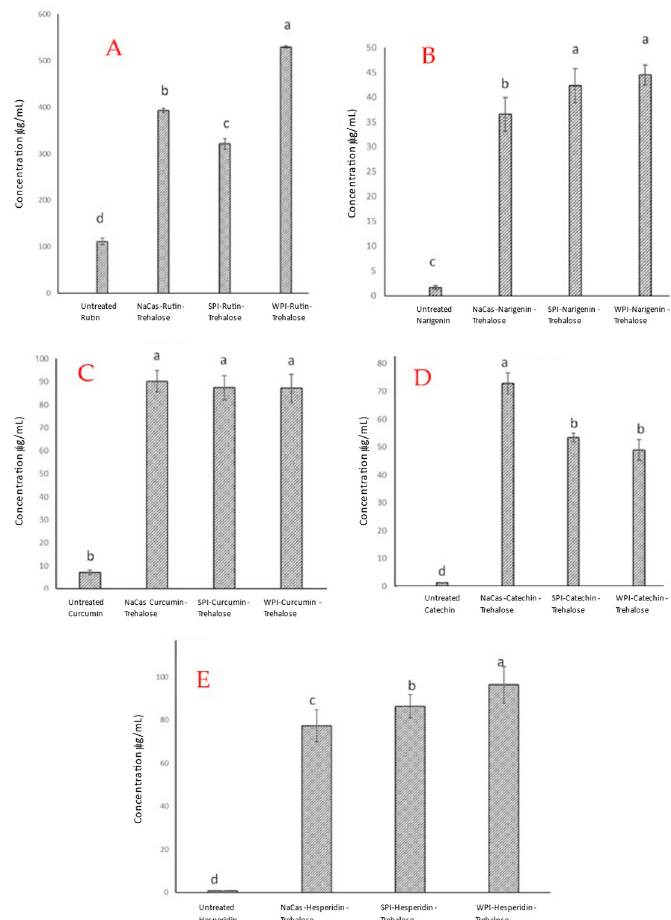
Figure 5. The water solubility of untreated (commercial) polyphenols and the polyphenols co-precipitated with different proteins in the presence of trehalose. NaCas: sodium caseinate, SPI: soy protein isolate, and WPI: whey protein isolate. ( A ) Rutin; ( B ) naringenin; ( C ) curcumin; ( D ) catechin; ( E ) hesperidin. In each frame the bars are ordered left to right: untreated polyphenol, NaCas-polyphenol-trehalose, SPI-polyphenol-trehalose, WPI-polyphenol-trehalose, The values in the columns with di ff erent le tt ers are signi fi cantly di ff erent ( p < 0.05). Error bars represent standard deviations based on three replicates.